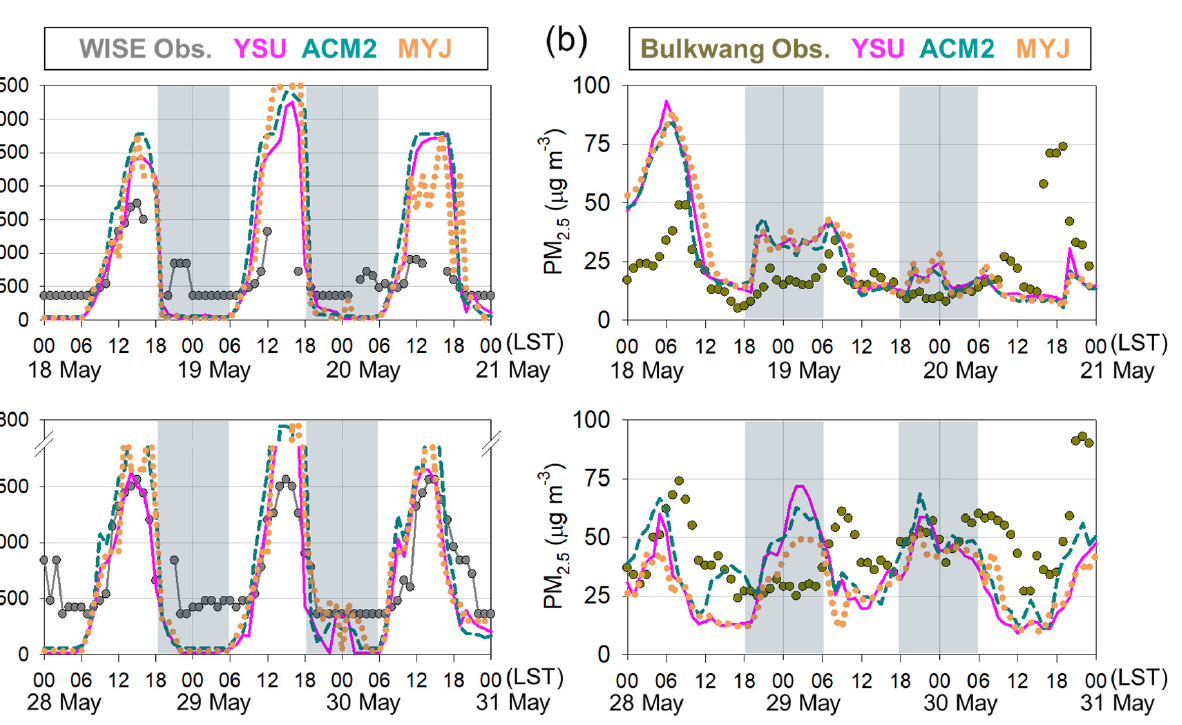
Figure 5. Temporal variations in ( a ) PBLH observations at the P3 site and ( b ) PM 2.5 observations at the Bulgwang site compared with simulations using the YSU, MYJ, and ACM2 PBL schemes for the periods 18–21 May and 28–31 May 2016. Gray shaded area indicates night.